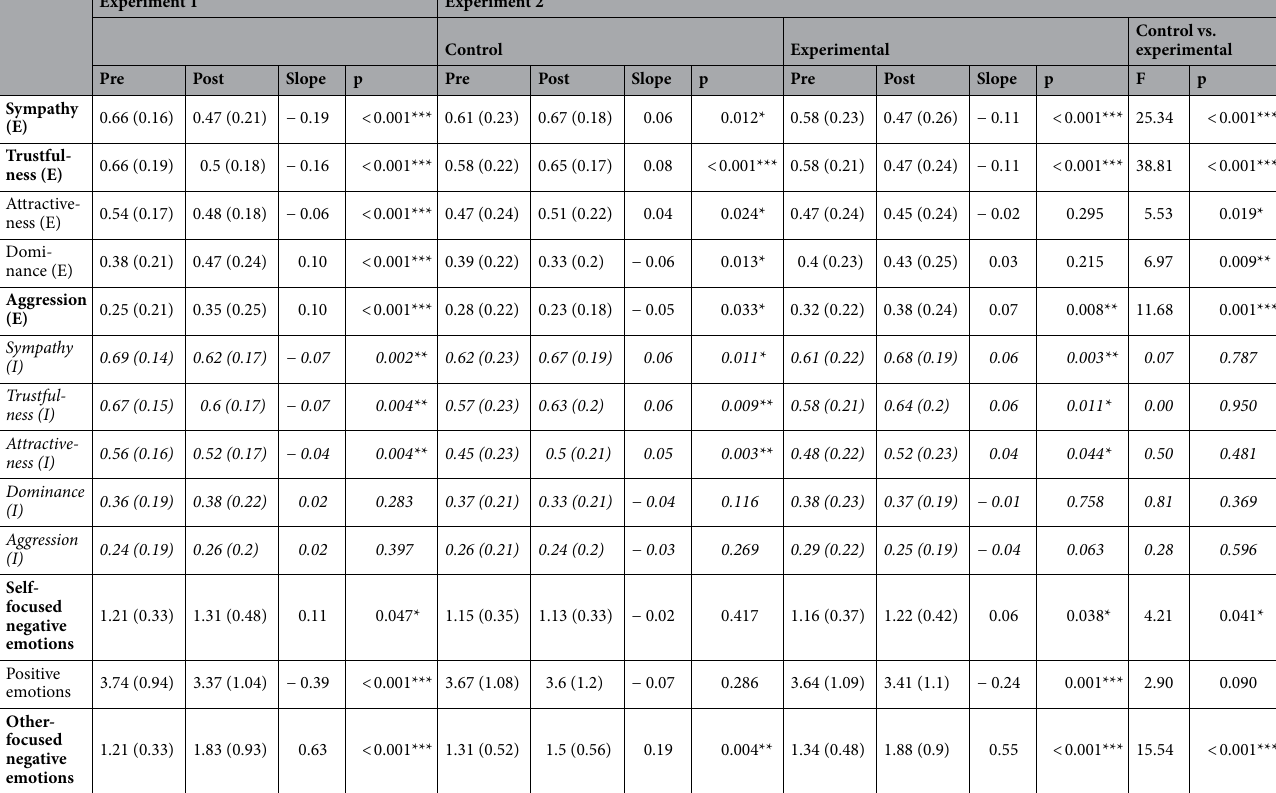
Table 4. Emotional reactions and ratings of other players. Descriptive statistics and results of Linear Mixed Models (LMM) analyses. E excluder, I includer; pre and post values reported as mean (SD); significance of pre- post LMM slope coefficients computed using Wald-Tests; significance of LMM factor interaction computed using Type III analysis of variance with Satterthwaite’s method, personal characteristics rating for includer are highlighted in italics. Exclusion induced changes in the ratings of personal characteristics and emotions that show similar effects in both experiments and can thus be considered as replicated, are highlighted in bold. * p < 0.05; ** p < 0.01; *** p <